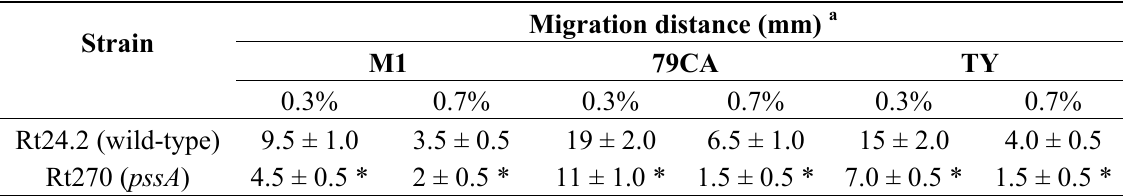
Table 1. Motility of the Rhizobium leguminosarum bv . trifolii wild-type and the pssA mutant strains assayed in different